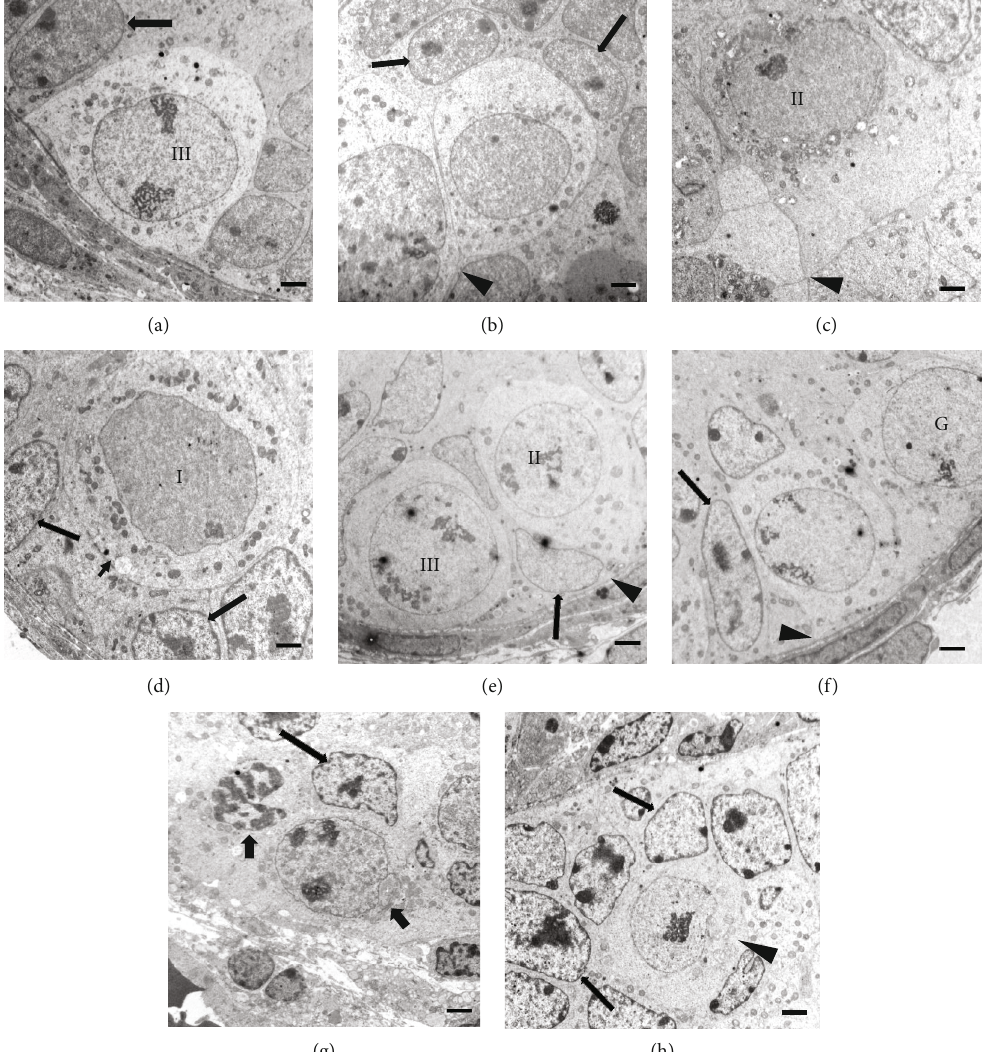
Figure 2: Seminiferous cords of the testes of control and animals with nicotine administration. (a, b) Control of 3 dpp, where we could observe subtype III gonocytes in contact with the basement membrane and in the process of migration to the basement membrane, with cytoplasmic projections extending toward the basal membrane (arrowhead) and Sertoli cell nuclei (arrow). (c, d) The nicotine group of 3dpp, where we can appreciate subtype I and II gonocytes, some in the process of migration to the basement membrane with cytoplasmic projections extending toward the basement membrane (arrowhead) that could be observed to be in degeneration. The other gonocyte is not in contact with the basement membrane (short arrow). (e, f) Control of 7dpp, where subtype III gonocytes in contact with the basement membrane and spermatogonia can be appreciated. Cytoplasmic projections extending toward the basement membrane can be observed (arrowhead). (g, h) The nicotine group of 7dpp, where we can observe degenerated gonocytes (short arrow) and gonocytes without contact with the basement membrane (arrowhead). I = subtype I gonocytes; II = subtype II gonocytes; III = subtype III gonocytes; large arrow = Sertoli cell nucleus, and G = spermatogonia. Electron microscopy. Bar scale: 2 μ